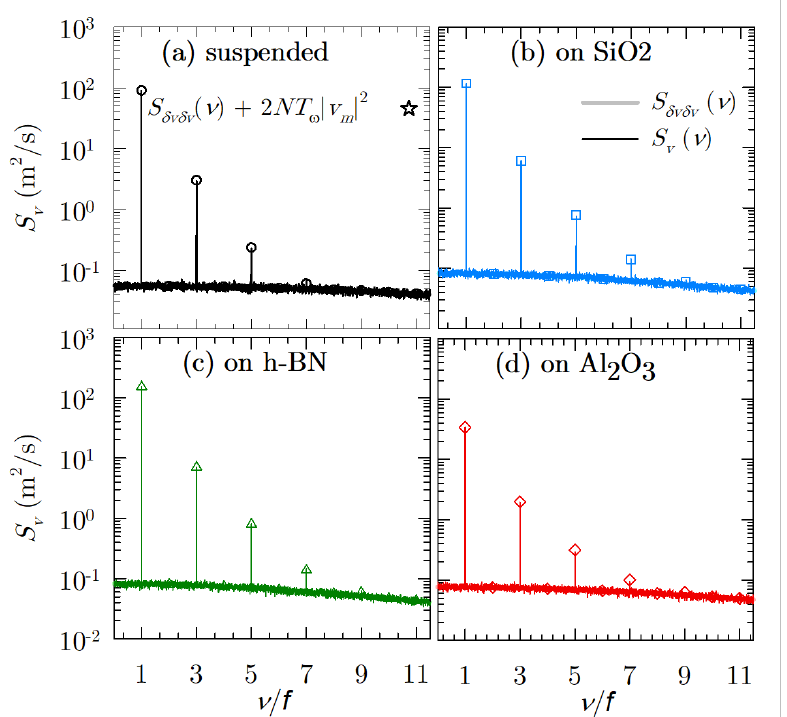
Figure 7. Full spectrum of velocity response for all the considered cases with E AC = 20 kV/cm and N = 300